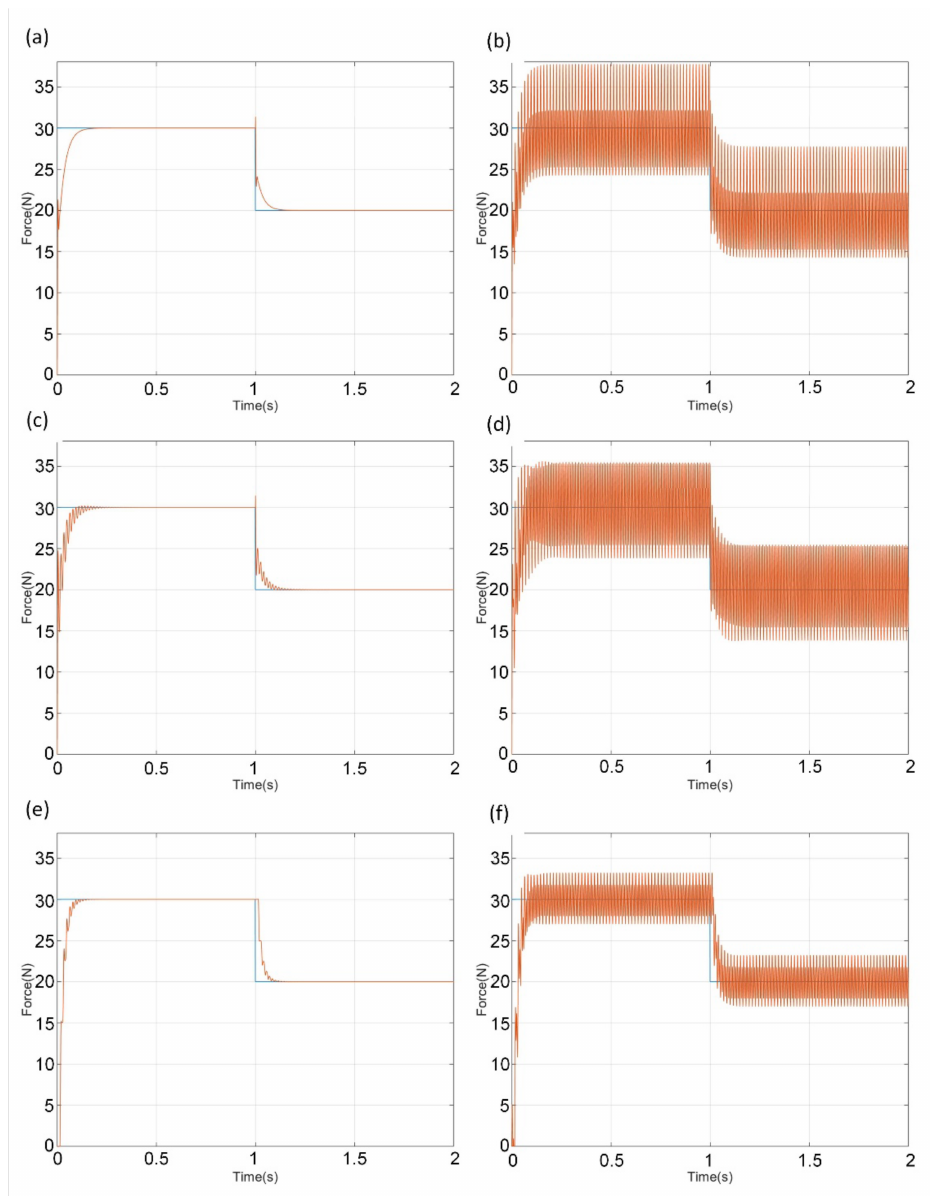
Figure 10. Simulation results of the model: ( a ) PID controller w/o disturbance; ( b ) PID controller with disturbance; ( c ) PID controller and peak filter w/o disturbance; ( d ) PID controller and peak filter with disturbance; ( e ) Repetitive controller w/o disturbance; ( f ) Repetitive controller with